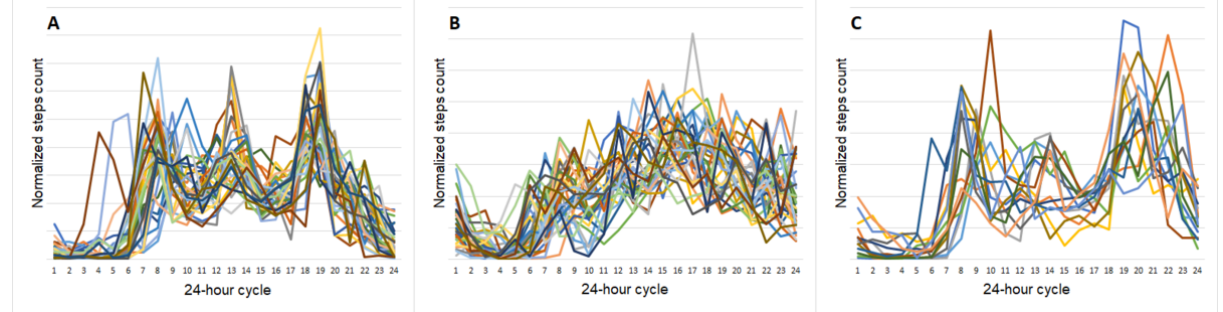
Figure 3. Visualization of normalized average 24-hour activity profiles by clusters. A: first cluster (N=35); B: second cluster (N=34); C: third cluster (N=14). Each line represents an individual within a cluster. x-axis: hours in a daily cycle. y-axis: average number of steps normalized by an individual sum of steps in average 24-hour